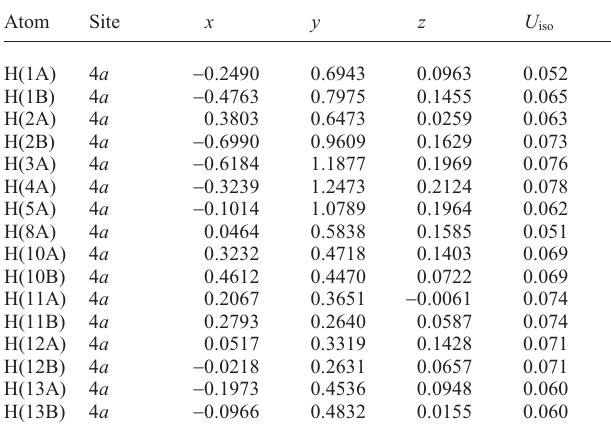
Table 2. Atomic coordinates and displacement parameters (in Å 2 )